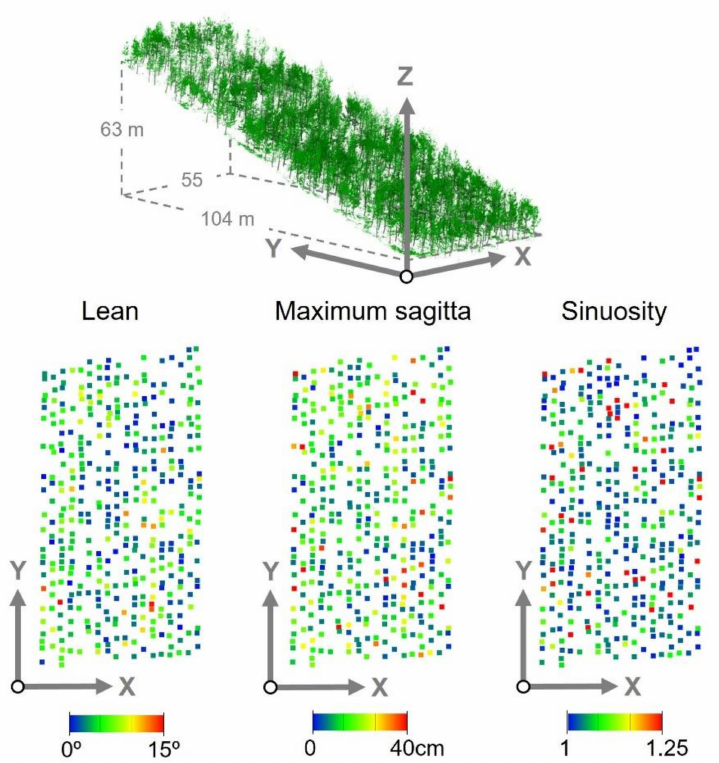
Figure 7. Spatial distribution of the stem-shaped variables (lean, maximum sagitta, and sinuosity) within the study plot. Top: 3D representation of the plot. Bottom: top views of the trees represented by a colored point indicating the stem shape value according to a color scale (blue: lowest value and red highest value within the study